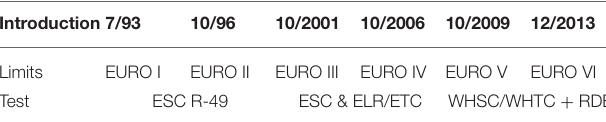
TABLE 4 | Emission limits for heavy duty vehicles (DELPHI Technologies,